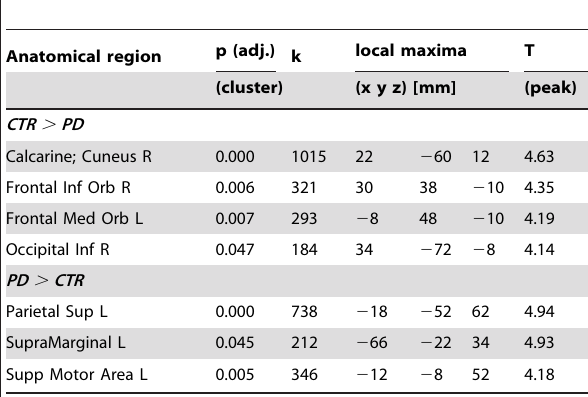
Table 3. Between-group differences in voxel